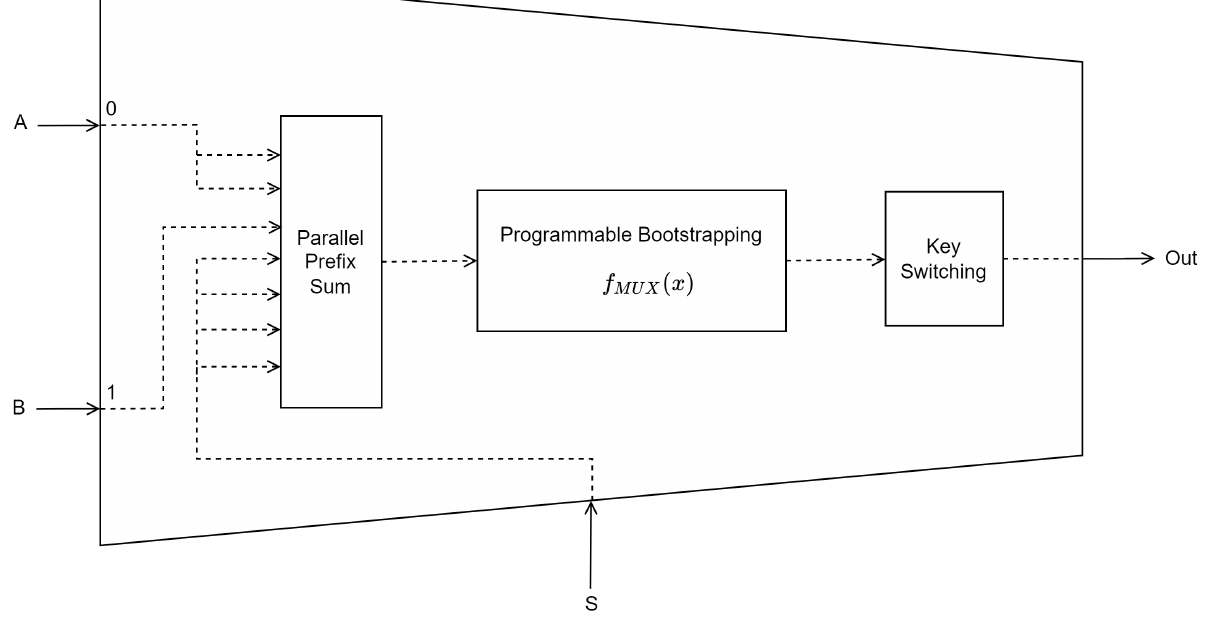
Figure 7. Multiplexer with encrypted inputs and